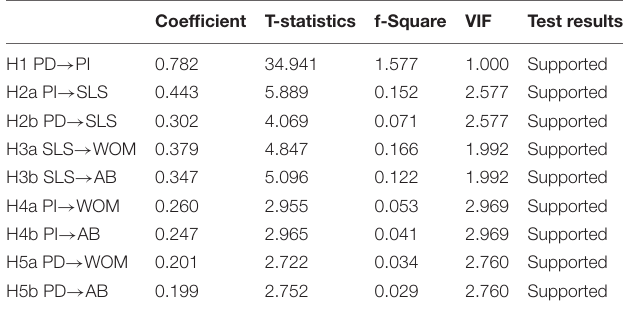
TABLE 5 | Results of hypotheses testing.